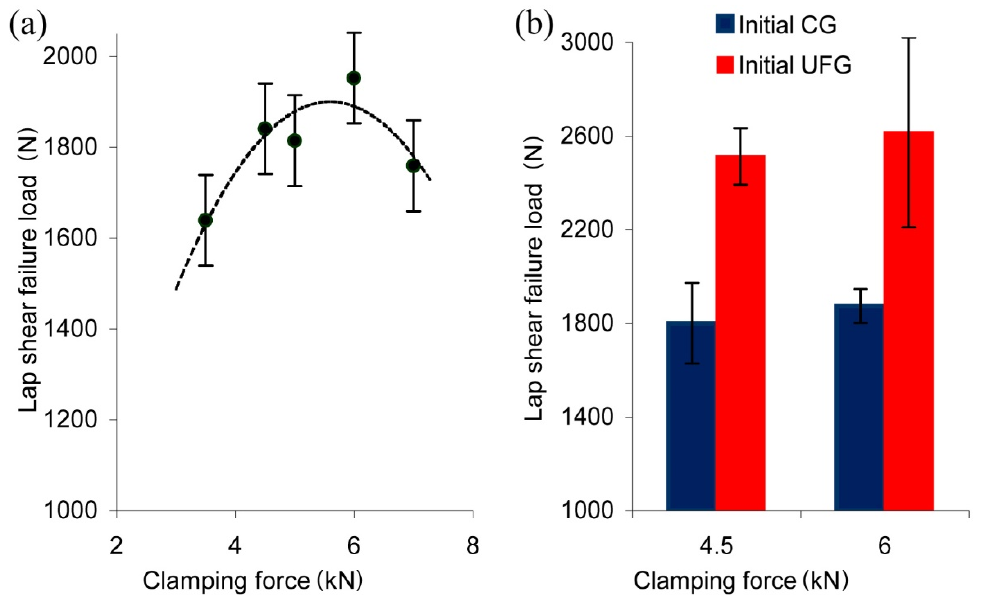
Figure 5. The dependence of the lap shear strength of welds made from Type 1 CG samples on the clamping force ( a ) and the lap shear strengths of the USW joints made from Type 2 CG sheets and UFG discs ( b ).